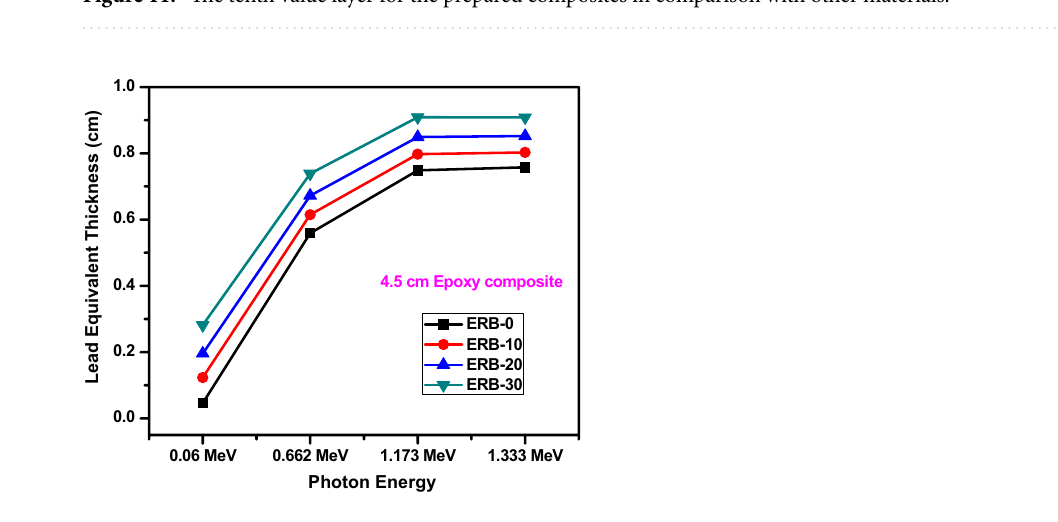
Figure 11. The tenth value layer for the prepared composites in comparison with other materials.